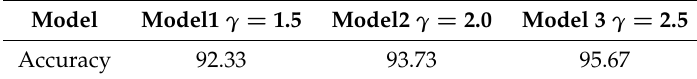
Figure 6. Three models including the upper, the mid, and the lower membership functions. Table 1. Average accuracies of the three